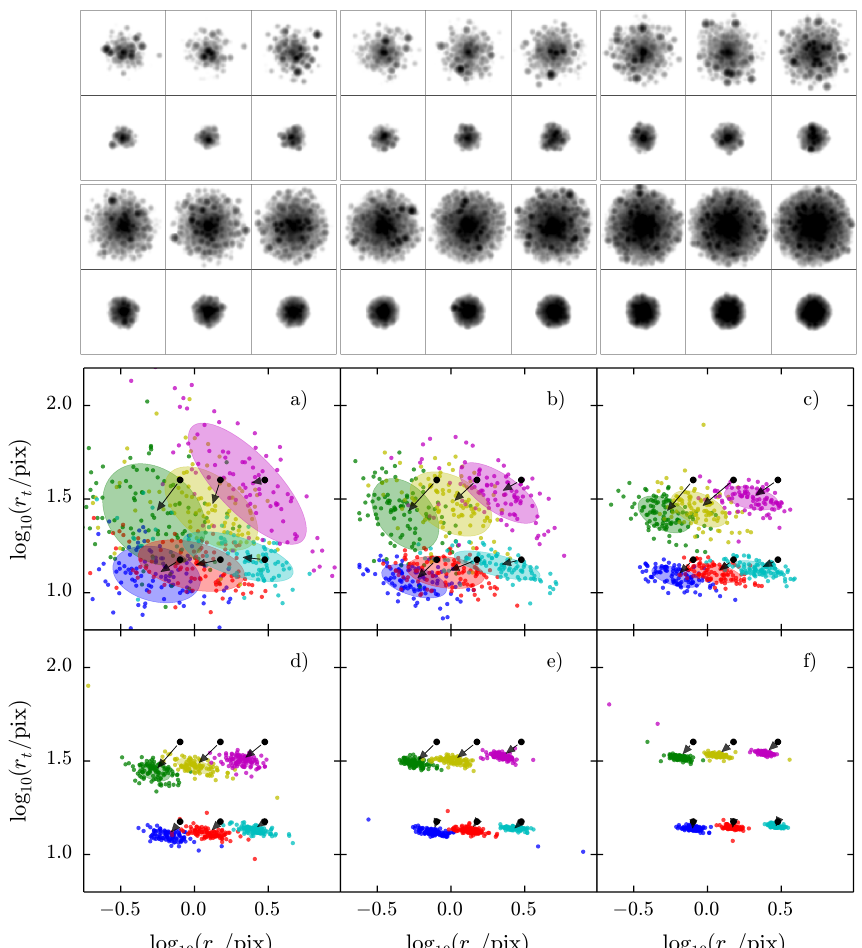
Fig.1. 10 Myr cluster. Blocks: top – V -band images without sky background, bottom – King model fit results. Panels in each block show clusters with mass: (a) 3 · 10 3 , (b) 10 4 , (c) 3 · 10 4 , (d) 10 5 , (e) 3 · 10 5 and (f) 10 6 M (cid:12) . Six example images in each panel of top block correspond to the input structural parameter nodes marked by black dots in the bottom block. Colored dots show